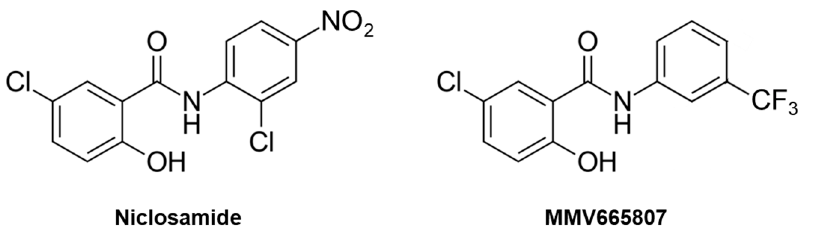
Figure 1. Chemical structure of niclosamide and MMV665807: Both compounds are salicylanilides, i.e., amides of salicylic acid and aniline.